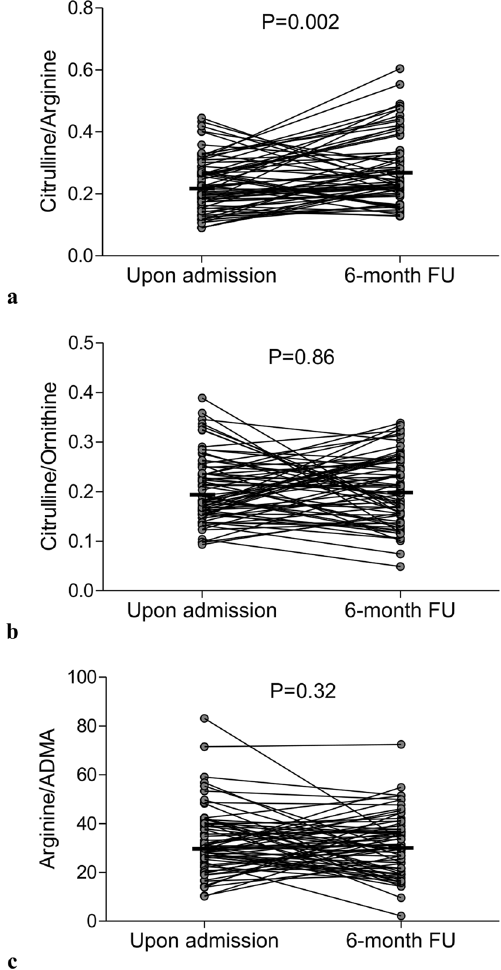
Figure 1. The shifts of balance of arginine metabolites between acute phase of myocardial infarction and stable chronic conditions. Following ischemia ( a ) citrulline/arginine index decreased when compared with stable chronic conditions while ( b ) citrulline/ornithine and ( c ) arginine/ADMA indices maintained unchanged. Data are shown as absolute values, horizontal lines indicate medians. ADMA asymmetric dimethylarginine, FU